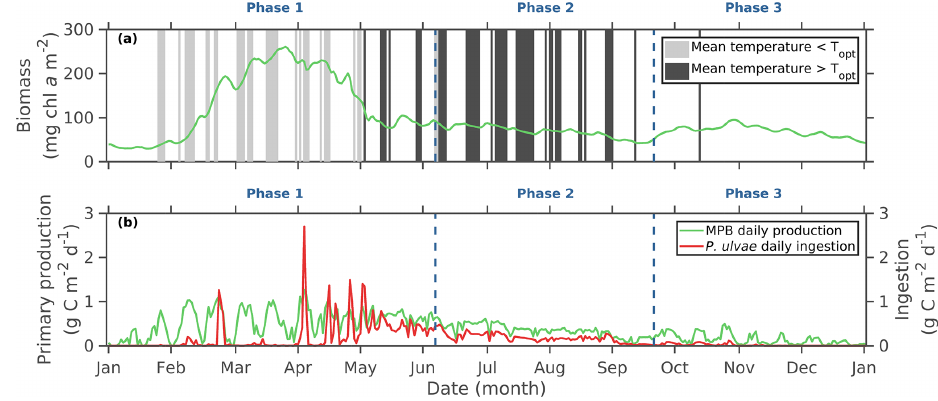
Figure 10. Seasonal cycle of the 2008 (a) simulated MPB biomass (mgChl a m − 2 , green full line) with time occurrence and duration (days) of the simulated temperature limitation term when daily averaged mud surface temperature during emersion periods was lower (grey vertical bars) or higher (black vertical bars) than the optimal temperature for MPB growth ( T opt ). (b) Simulated daily primary production rate